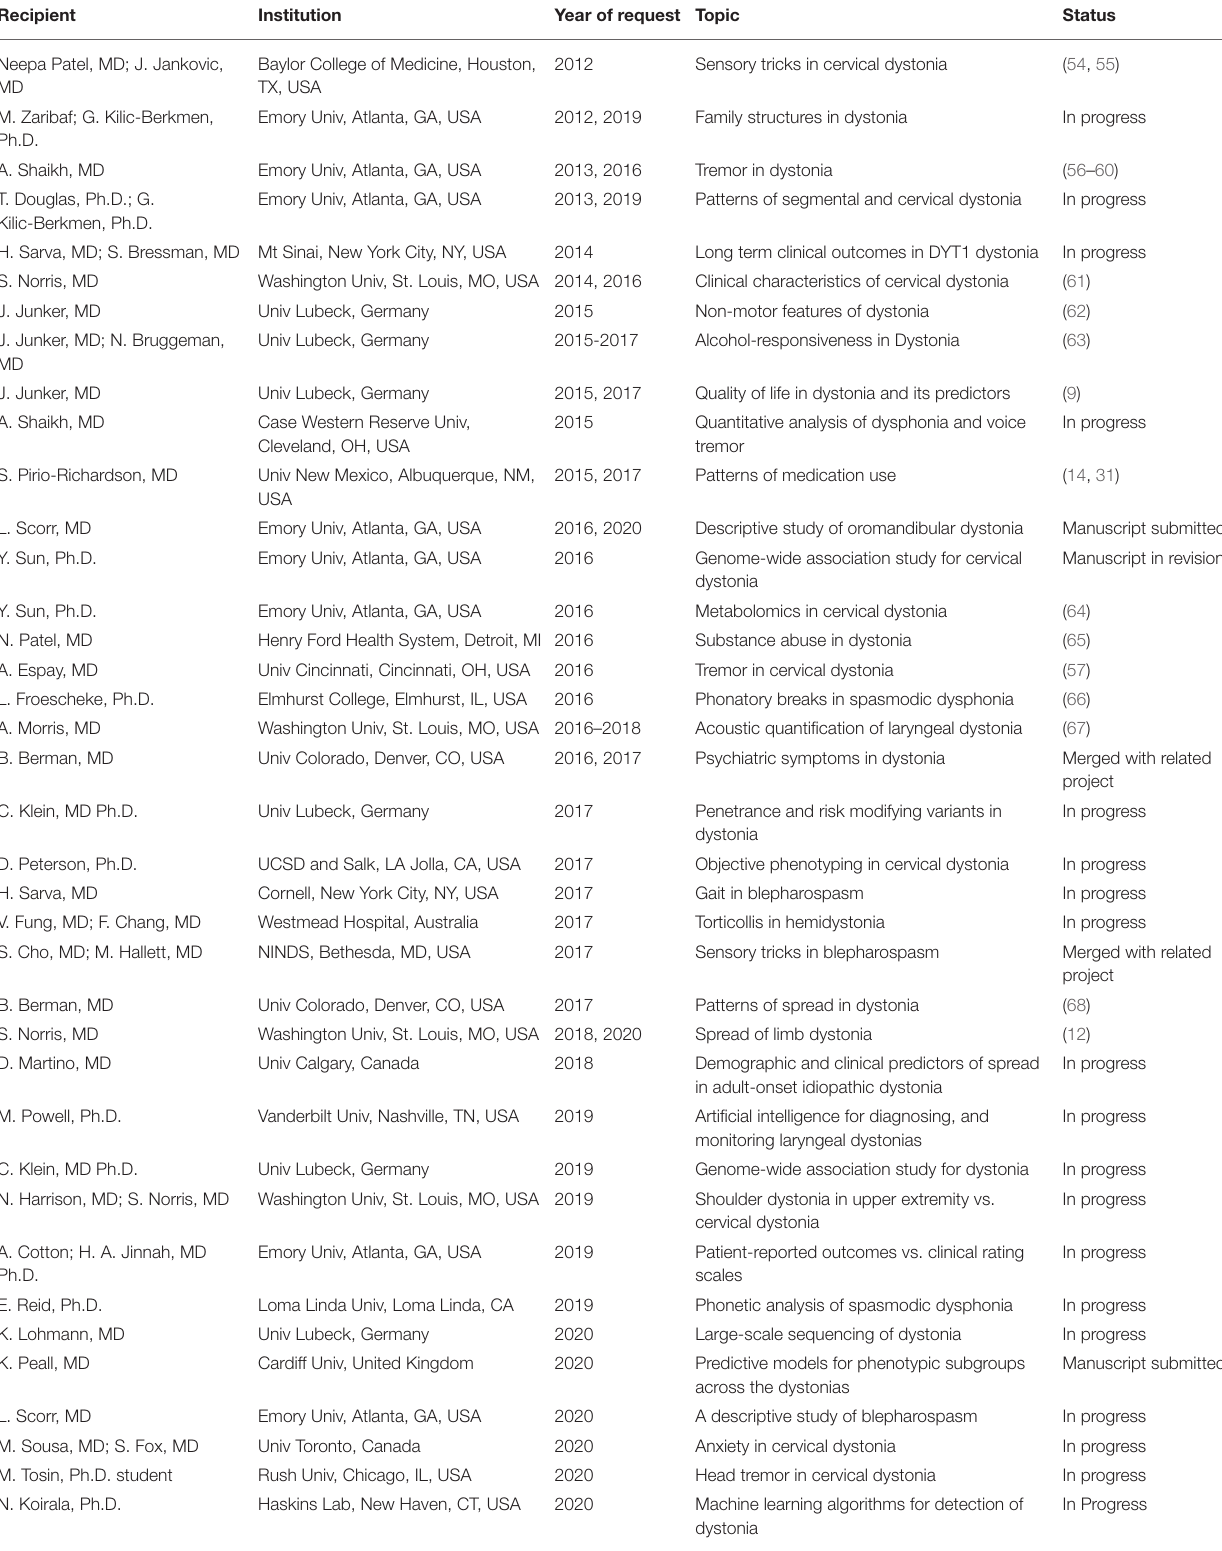
TABLE 5 | Pilot projects supported with Dystonia Coalition data or